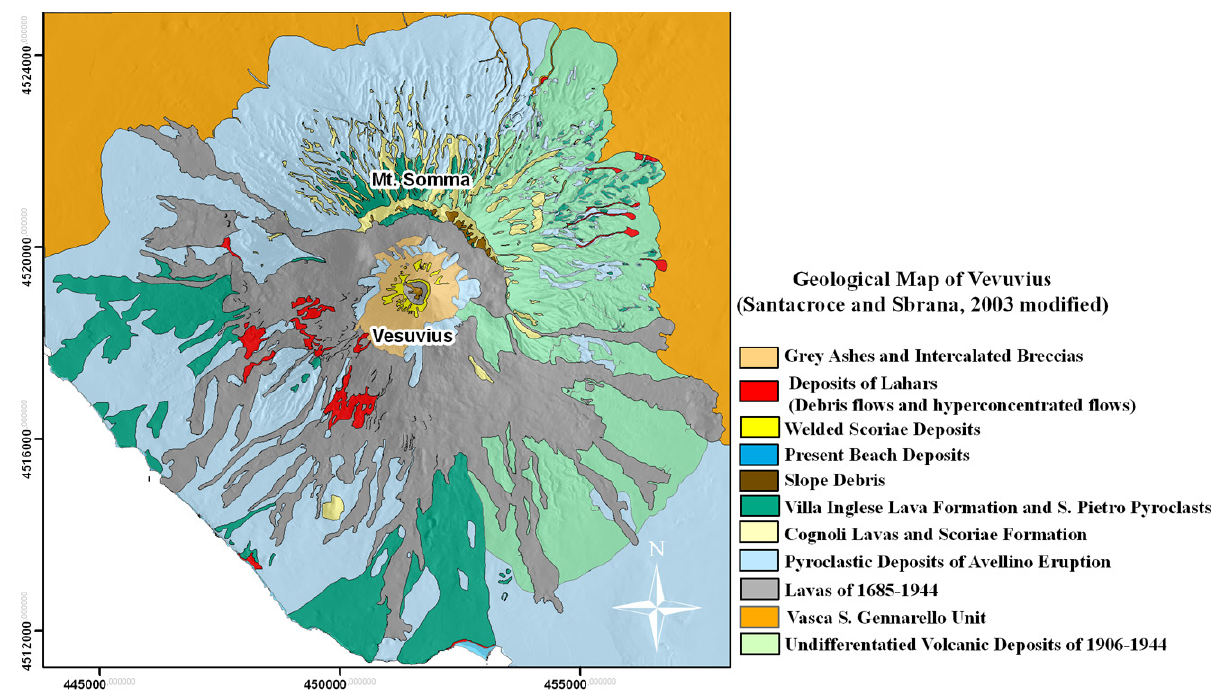
Figure 2. Geological Map of the Somma-Vesuvius volcanic complex (after Santacroce [1987], and Santacroce and Sbrana [2003],